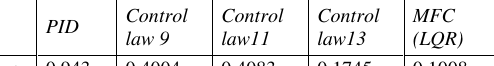
Fig 10e. Influence of turbulence with the use of control law (18) Table 3. Values of performance index